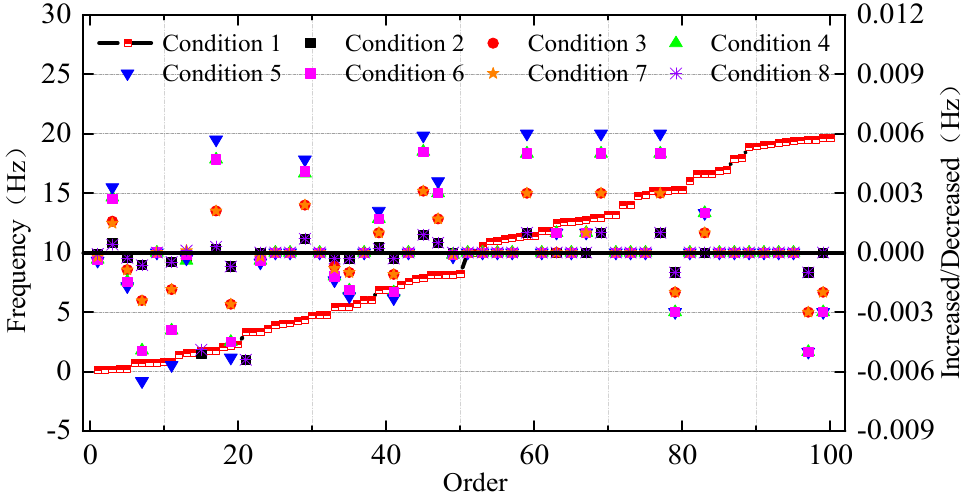
Figure 21. First 100 orders of inherent frequency of wind turbine under different conditions.